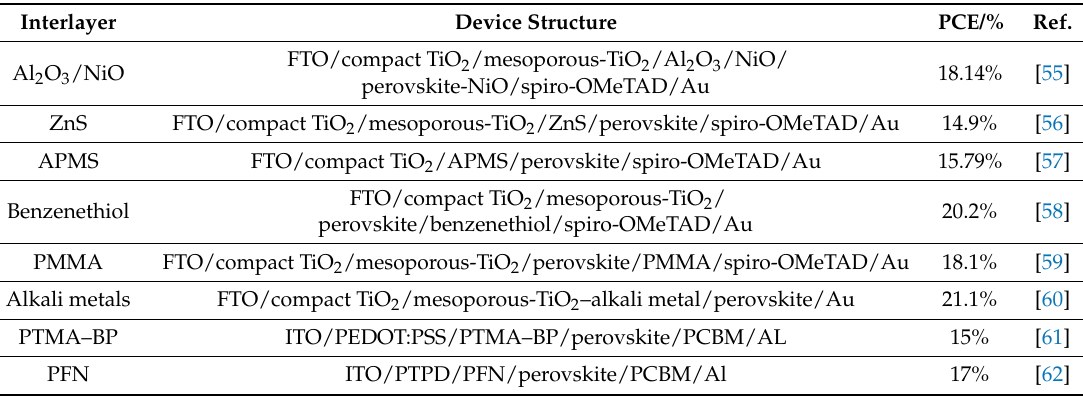
Table 3. Summary of research about improving the PCE of PSC by interfacial